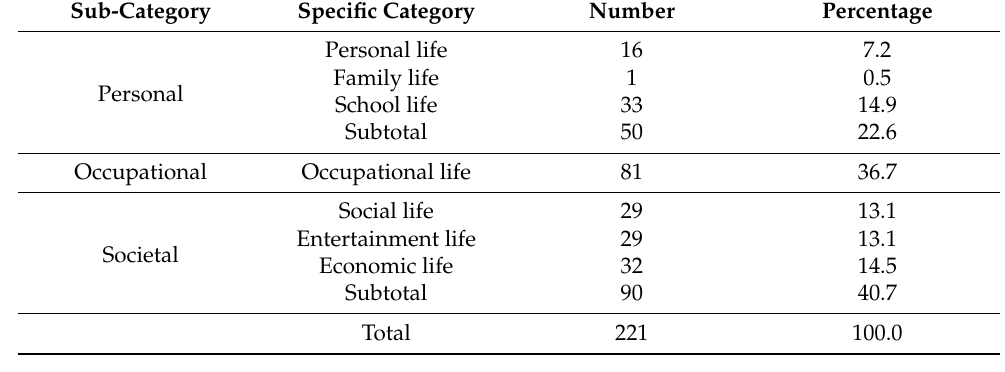
Table 5. The content distribution of the category of Social Roles .